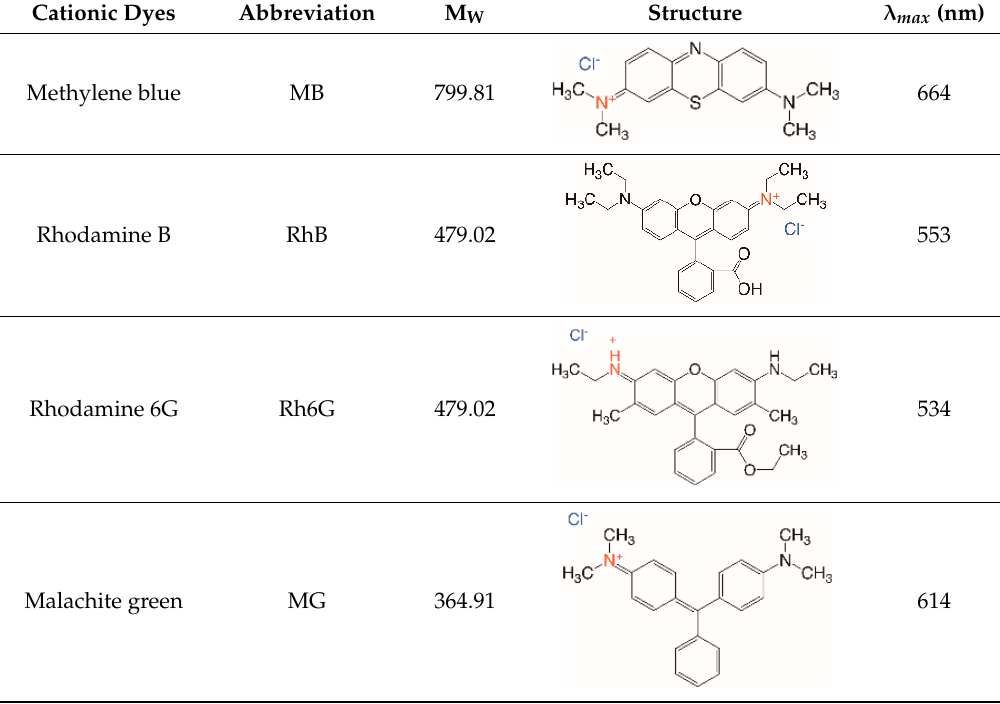
Table 1. Chemical properties of representative cationic and anionic dyes. M W —molecular weight. Cationic Dyes